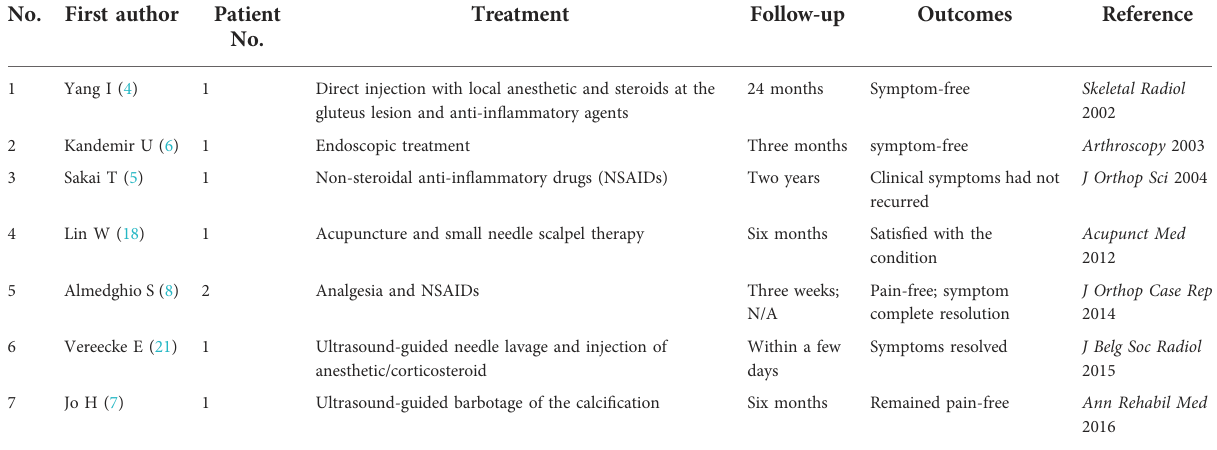
TABLE 1 Review of articles regarding the treatment of calci fi c tendinitis of the gluteus medius. No. First